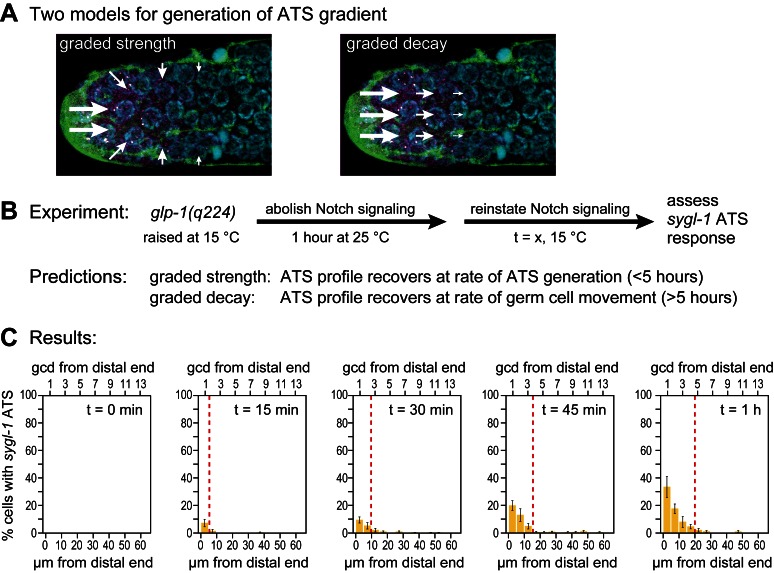
Graded sygl-1 transcriptional response likely reflects graded signaling strength.(A) Two models to generate graded sygl-1 transcriptional response. Left, DTC signaling is graded within the niche; right, signaling is primarily at distal end but decays as cells move proximally within the niche. (B) Above, experiment to monitor rate of ATS pattern establishment after being abolished. Below, prediction made by each model. (C) Graded response is re-established within 1 hr. Percentage germ cells with sygl-1 ATS as a function of distance at 15 min intervals during reformation. Red line marks the region with sygl-1 ATS, as in Figure 3A. Conventions as in Figure 3A; n = 21 gonads for each time point.